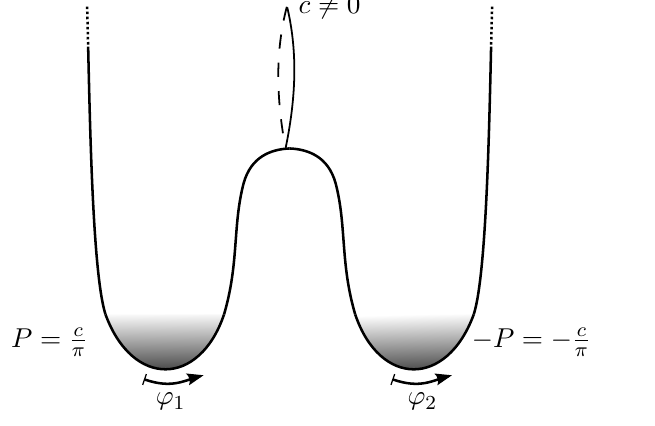
Figure 5 . Fluxes induced by non-vanishing c are localized at the tips of the